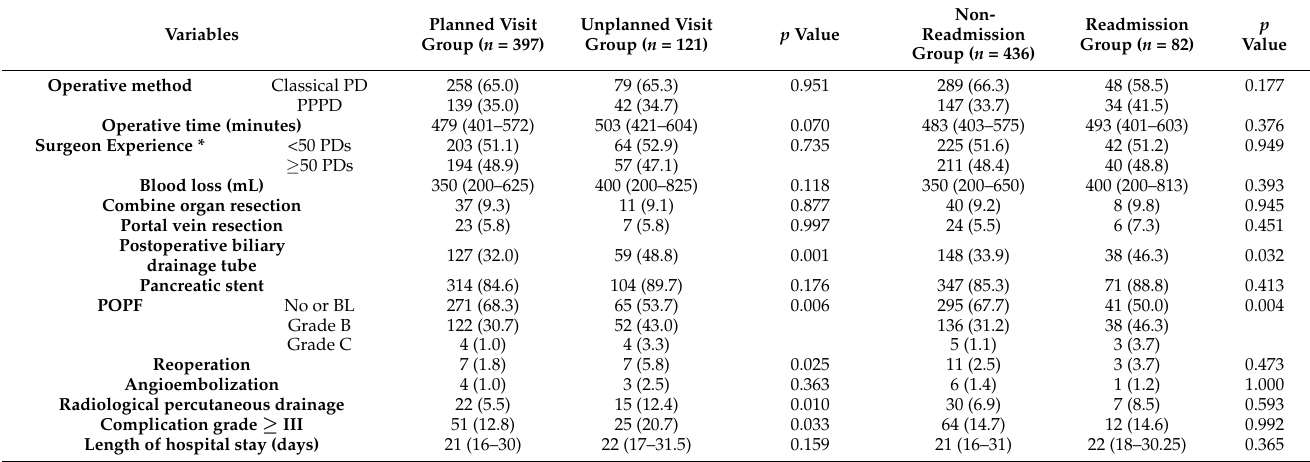
Table 3. Operative details and postoperative events during index hospitalization of patients catego- rized by unplanned hospital visit or readmission.